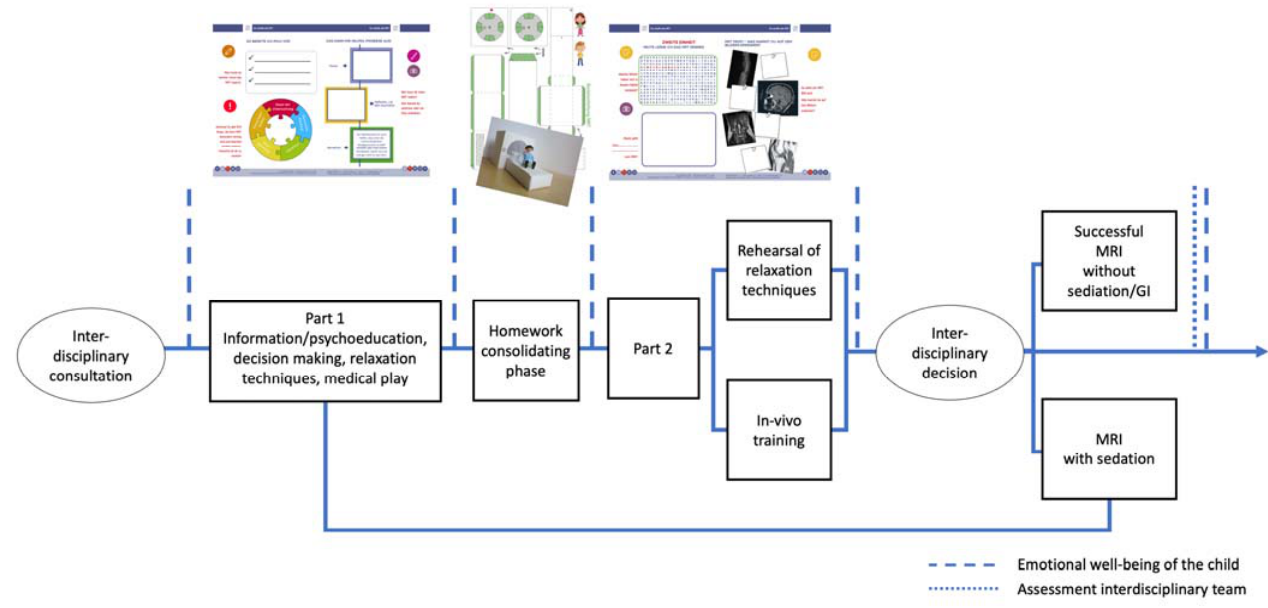
Figure 1. “iMReady”